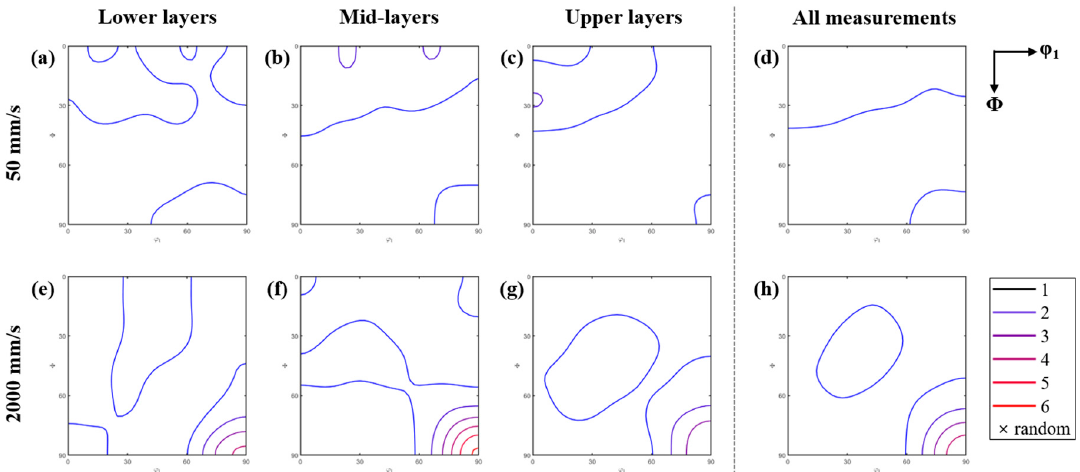
Figure 8. Orientation distribution functions (ODFs) on the ϕ 2 = 45 ◦ section of the Euler space (Bunge’s convention) according to the regions and the scan speeds of the AM objects (Refer to the left and the upper parts of the figure for the information on the regions and the speeds. The sample reference axes 1 and 3 correspond to SD and BD, respectively): ( a – d ) ODFs of the lower, the mid-, the upper layers and all the sampled regions of C50 respectively, ( e – h ) ODFs of the lower, the mid-, the upper layers and all the sampled regions of C2k respectively